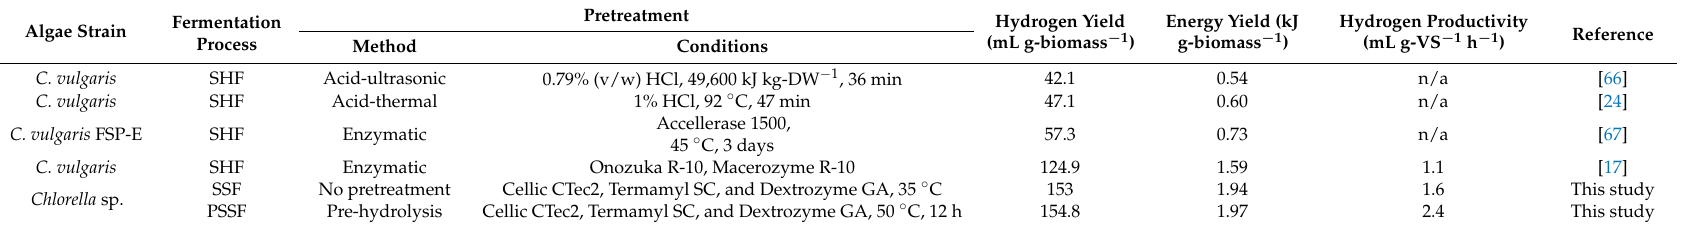
Table 3. Hydrogen yield and productivity obtained using Chlorella biomass as a